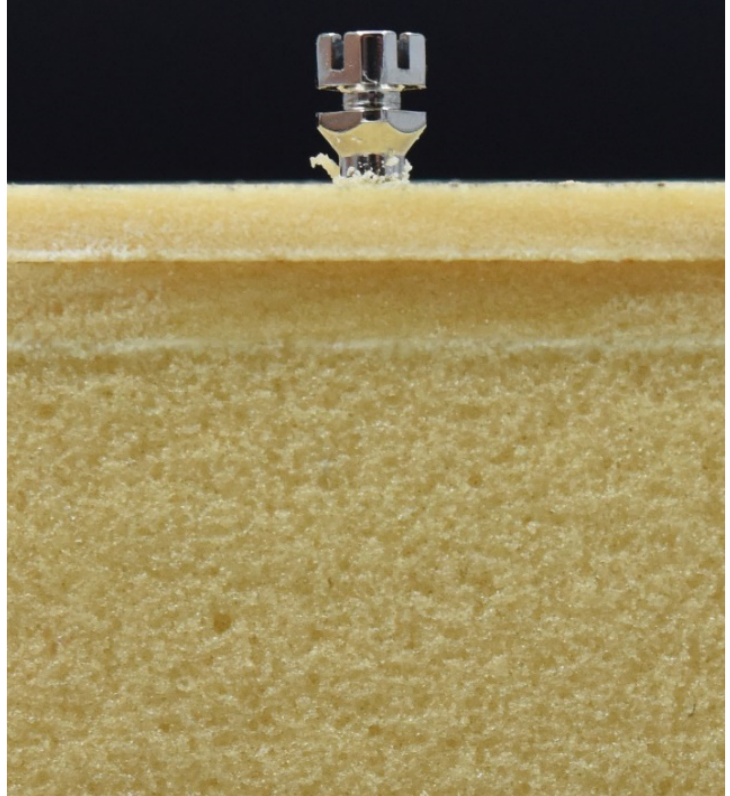
Figure 2. The bone block and the inserted miniscrew.